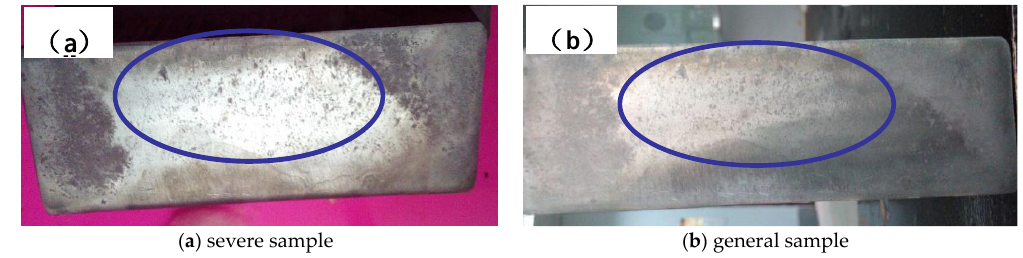
Figure 4. The 33MnCrTiB macro-corrosion morphology.